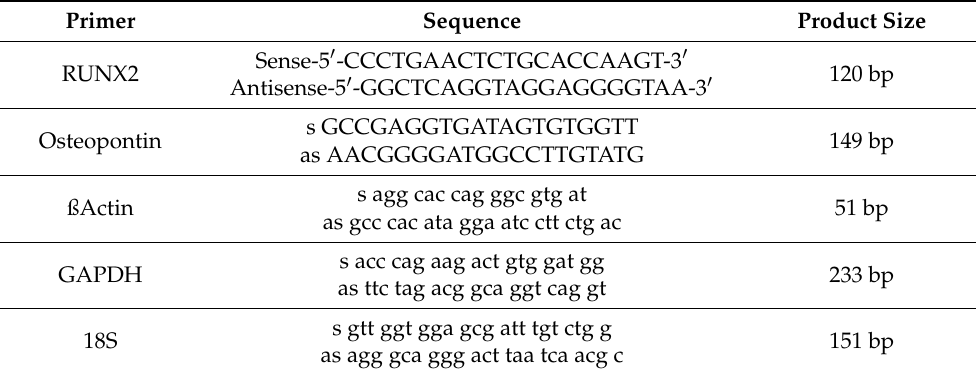
Table 1. Primer Pairs for the amplifications of target gene